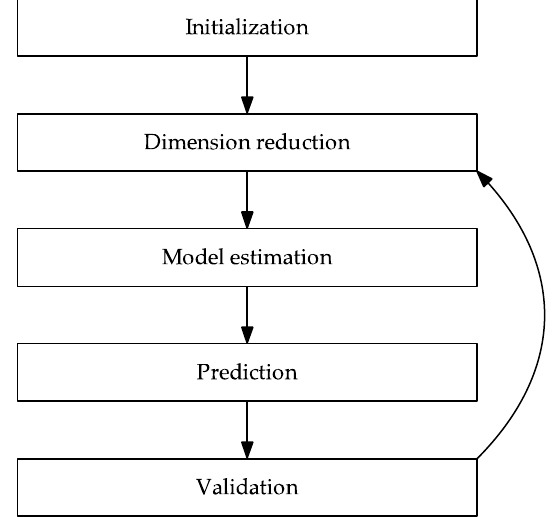
Figure 5. Steps of the sequential algorithm.